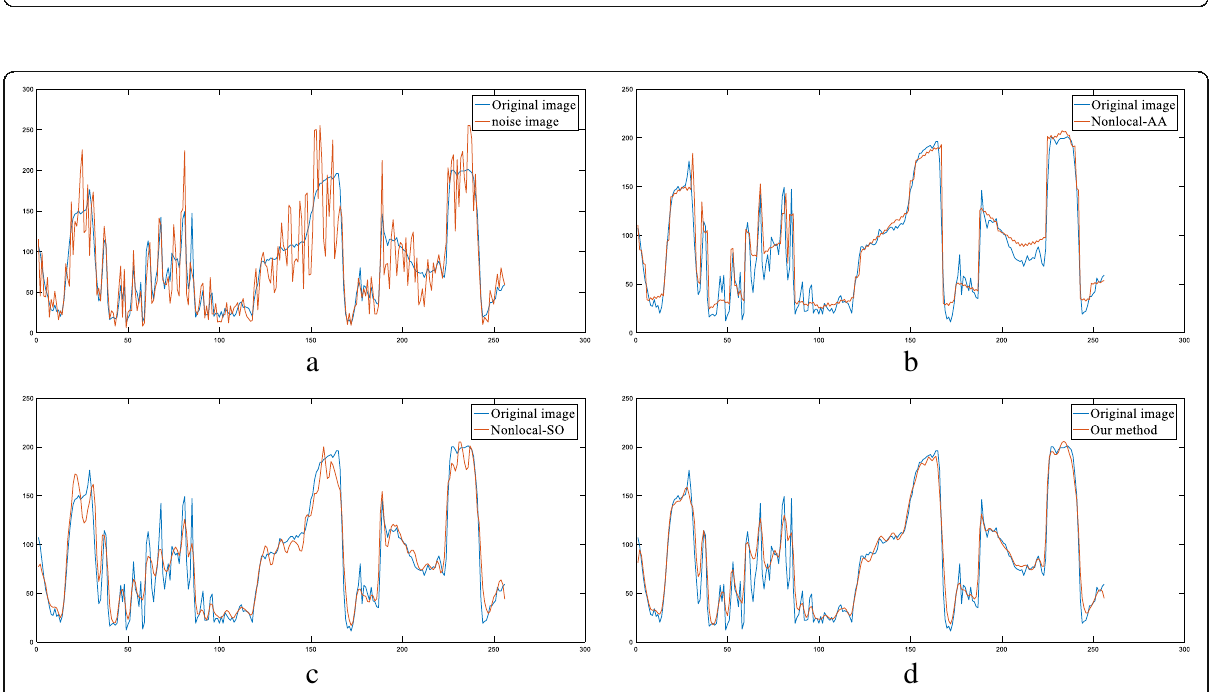
Fig. 2 Results of different models on the Lena image degraded by a Gamma noise of level with σ =0.05. a Noisy image, b nonlocal-AA, c nonloca-SO, and d proposed method